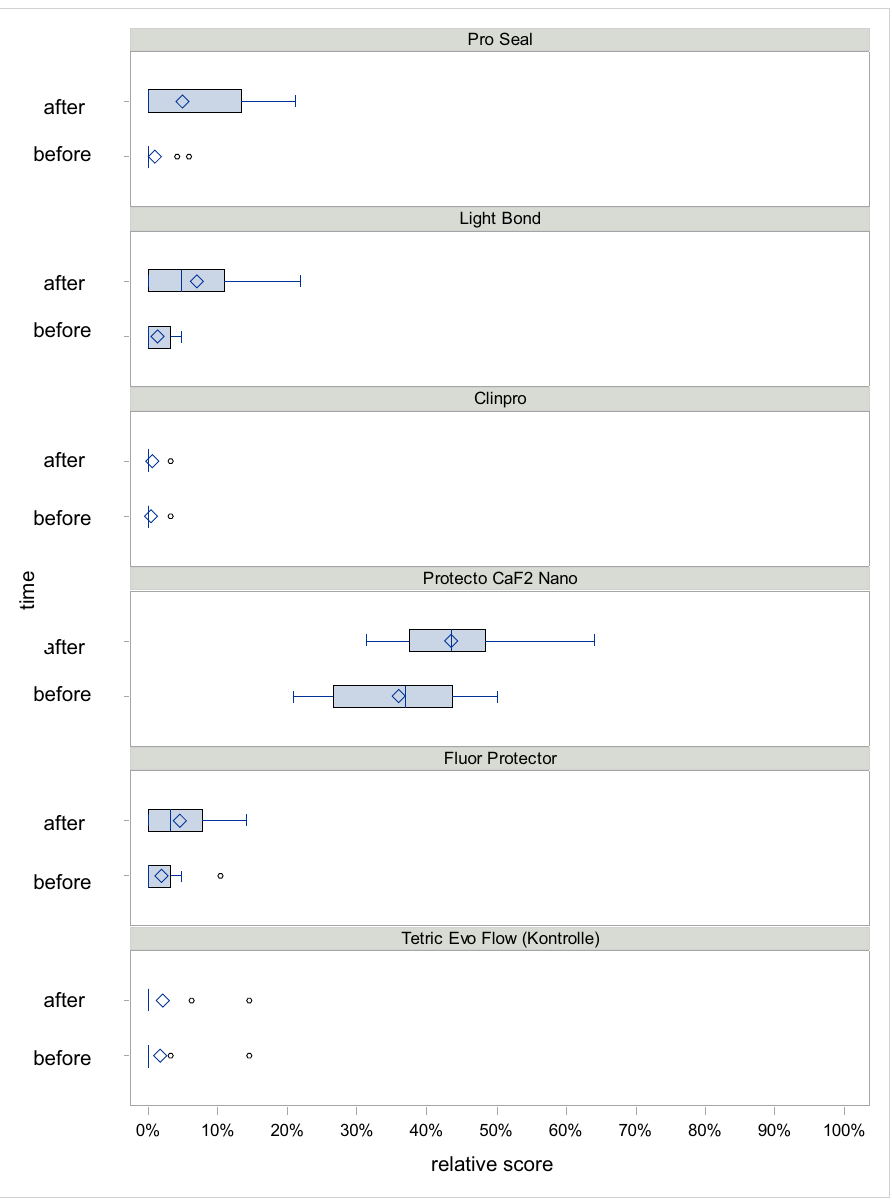
Figure 1. Boxplot diagram for the distribution of the relative material loss score over the different points in time, normalized to the number of evaluable surfaces under mechanical